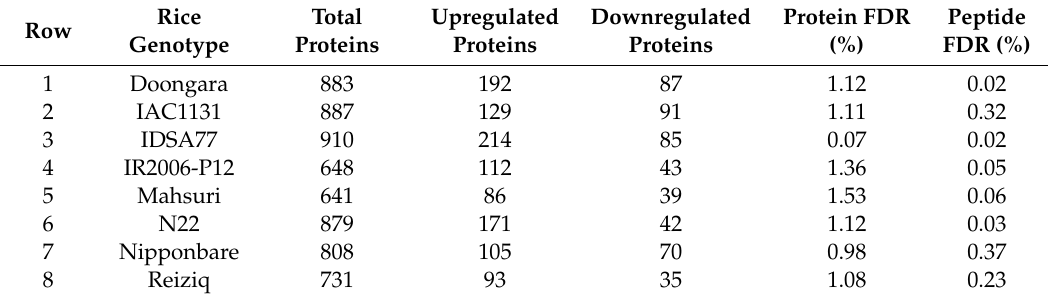
Table 1. Summary of the peptide and protein identification data of leaf samples for eight genotypes of